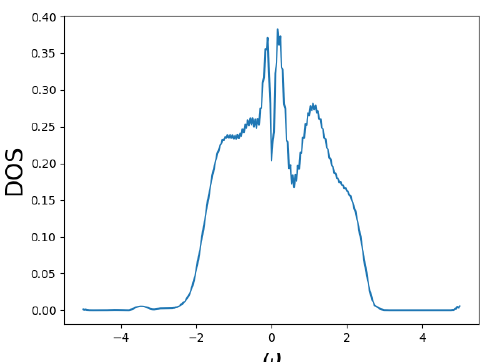
Figure 5. Spectra of the system at T = 0.025 and N = 0.98. The decrease in the density of states near ω = 0 supports our finding that the system is no longer in the Fermi liquid state.